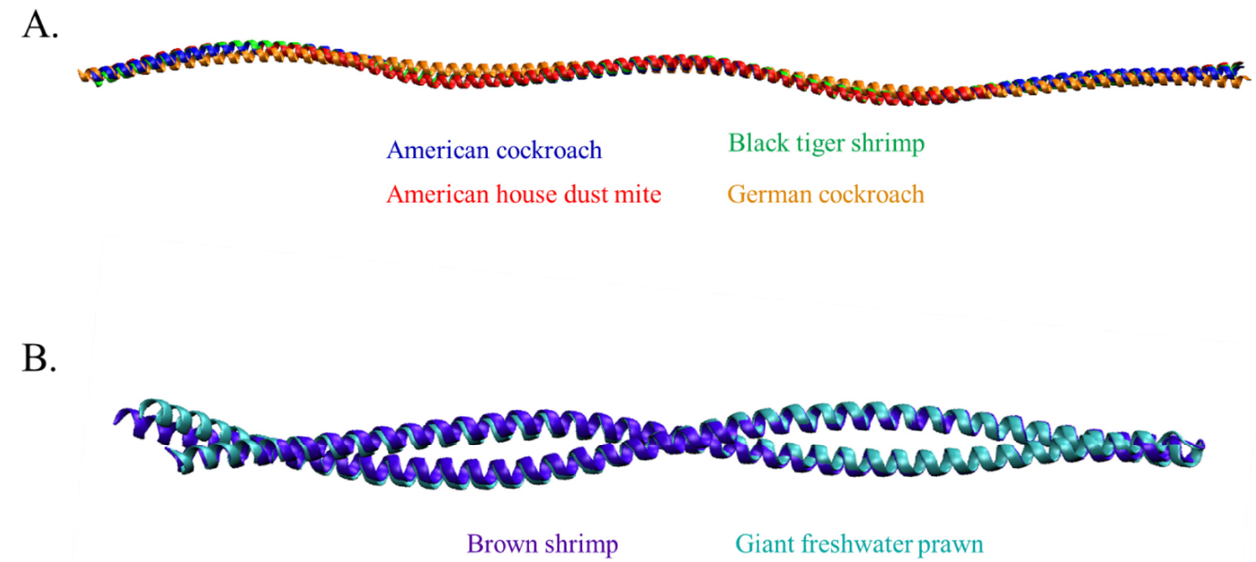
Figure 3. Predicted tropomyosin tertiary structures. ( A ) The comparison of tropomyosin structure derived from American cockroach, black tiger shrimp, American house dust mite, and German cockroach ( α -helical coiled-coil along the entire molecule). ( B ) The unnatural structure of tropomyosin predicted by Robetta server (self-assembly alpha parallel